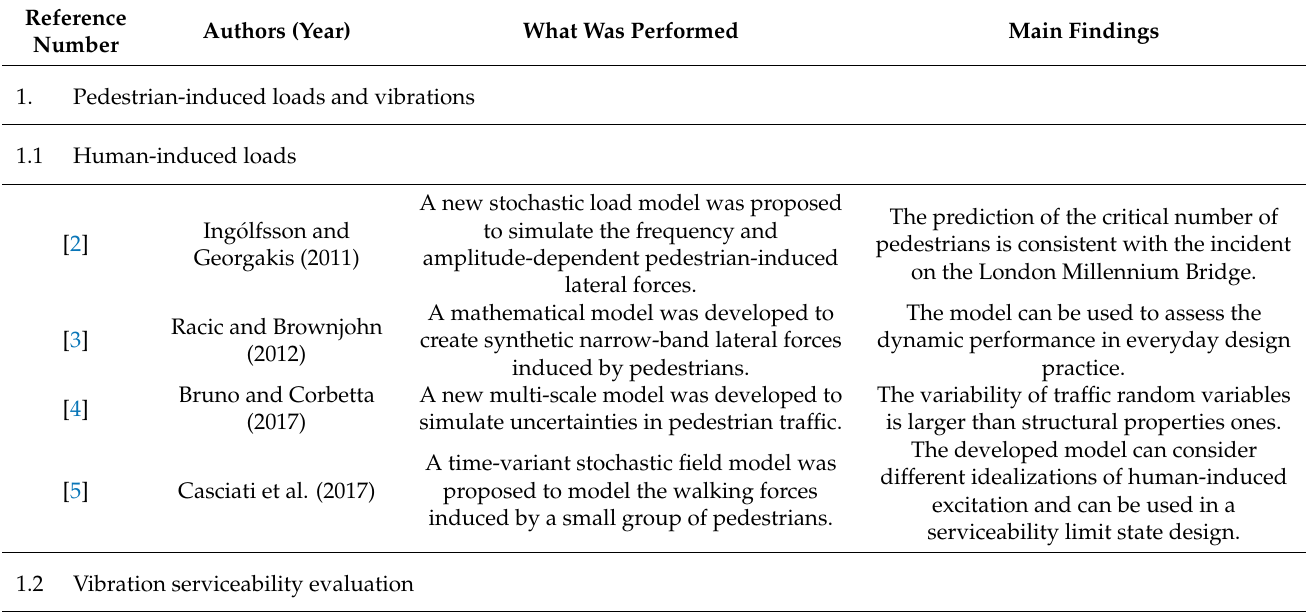
Table 1. Summary of related previous